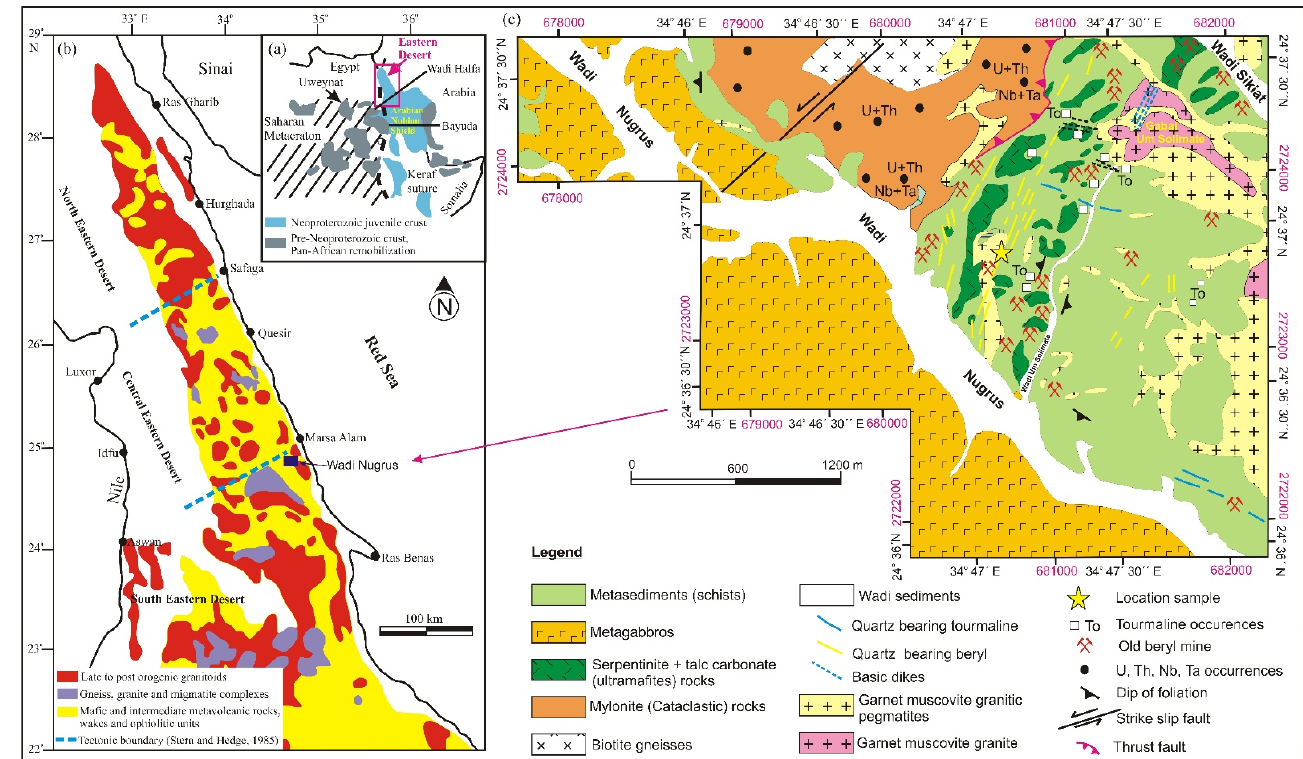
Figure 1. ( a ) Geologic map showing the Arabian Nubian Shield (ANS); ( b ) geologic map showing the basement rocks of Neoproterozoic age in the Eastern Desert of Egypt [35]; ( c ) geological map of Wadi Nugrus, South Eastern Desert, Egypt, after [43–46].